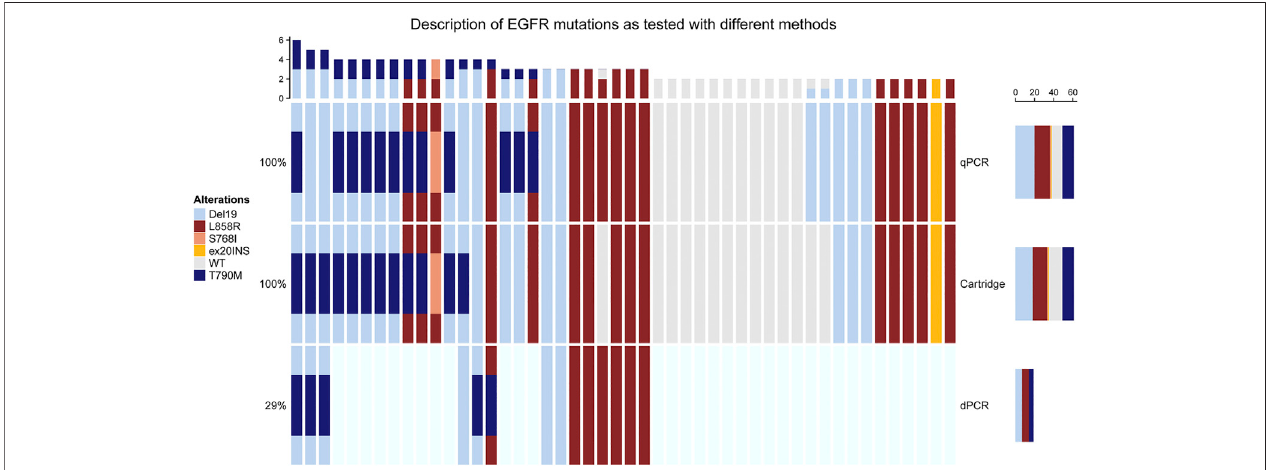
FIGURE3| Concordance ofmutations detected bythe cartridge-based system incomparison totheFDA approved qPCR based system foreach ofthemutation types. The number of samples with the respective mutations is shown in the middle if concordant, on the right side if only detected in the cartridge-based system or on the left side when only detected with the qPCR based